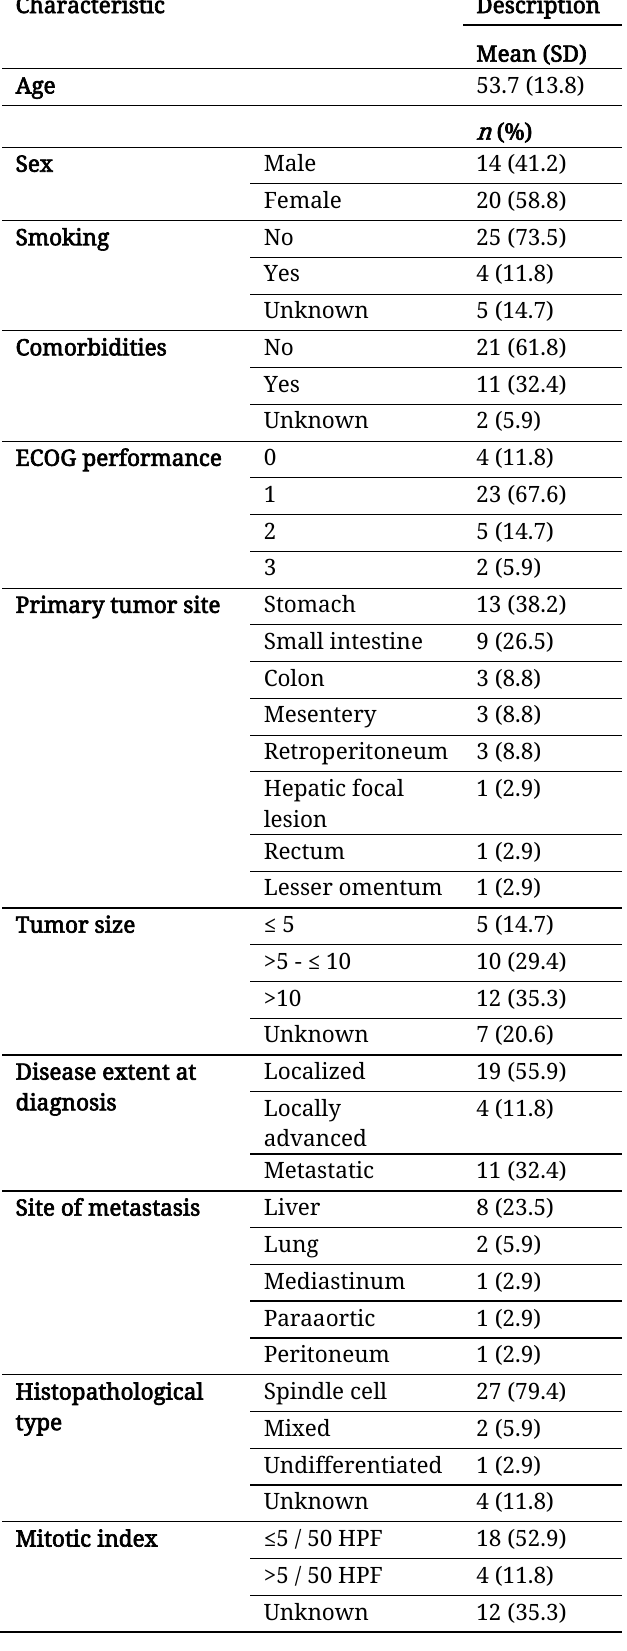
Table 1: Patient and tumor characteristics (n=34)